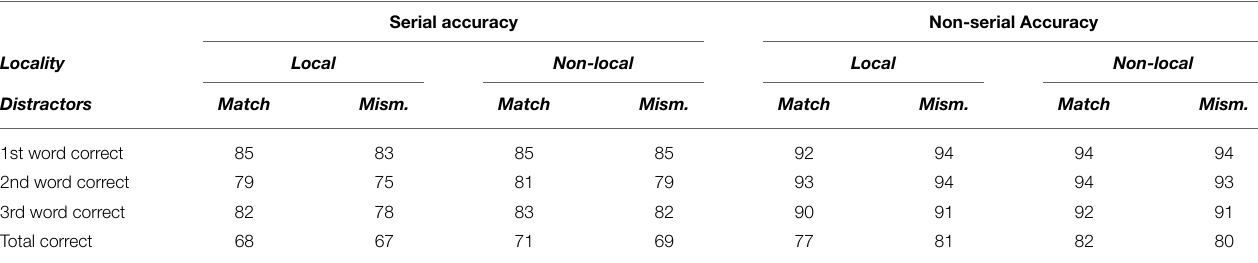
TABLE 7 | Experiment 2: Mean serial and non-serial recall accuracy in percentage of the three memory load words separately and total accuracy in percentage presented by experimental condition.